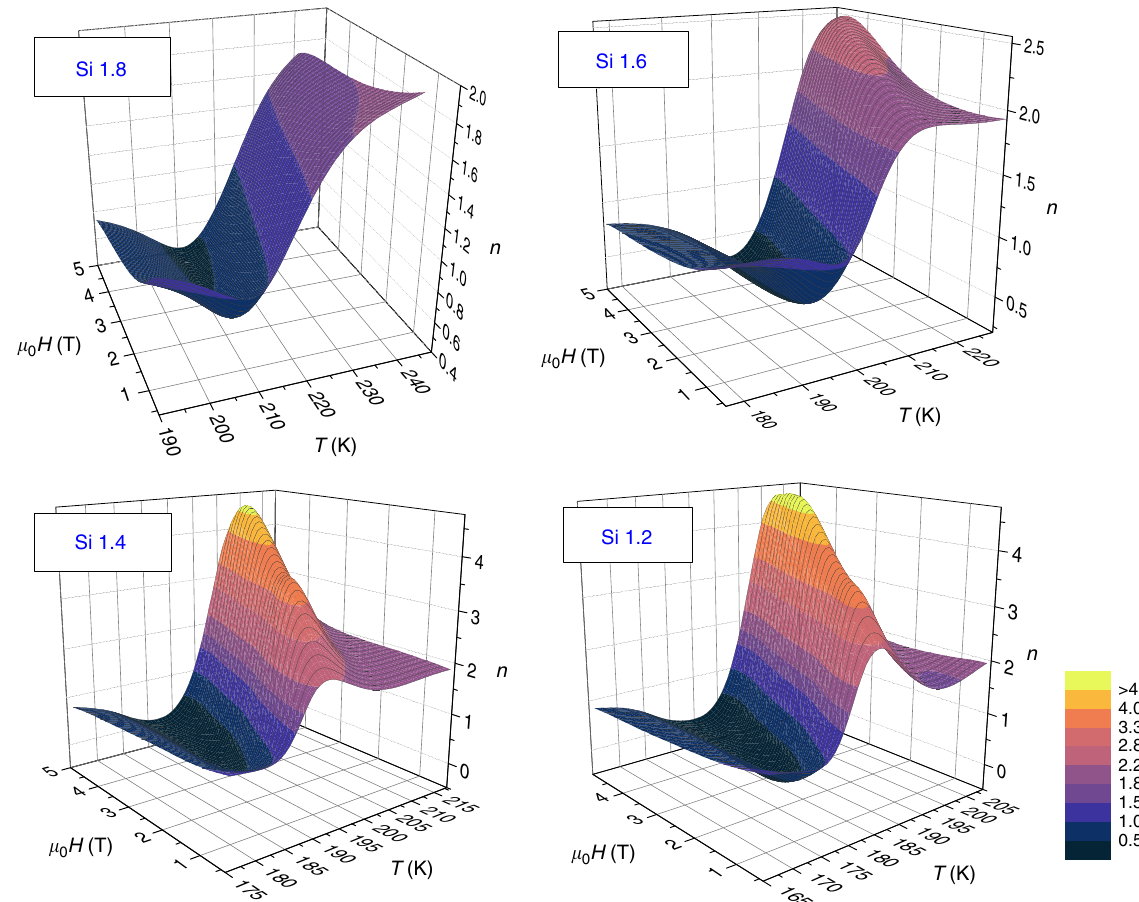
Fig. 4 Field and temperature dependence of the exponent n for La – Fe – Si alloys. The values of n > 2 for Si 1.2, 1.4, and 1.6 clearly indicate their FOPT behavior, while Si 1.8 is a